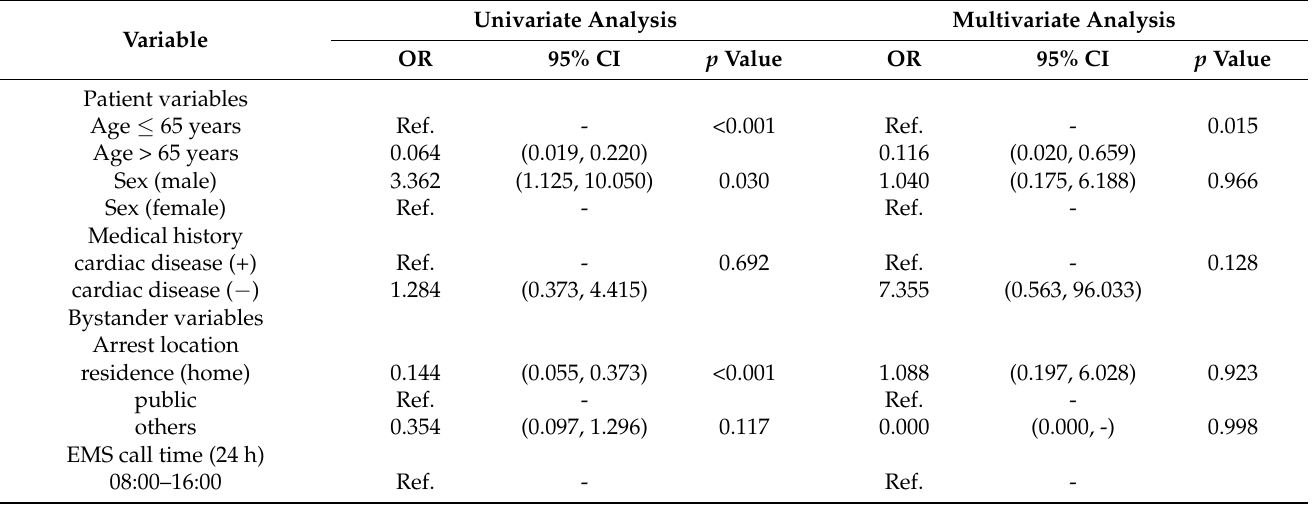
Table 5. Factors associated with survival to discharge after OHCA in the rural